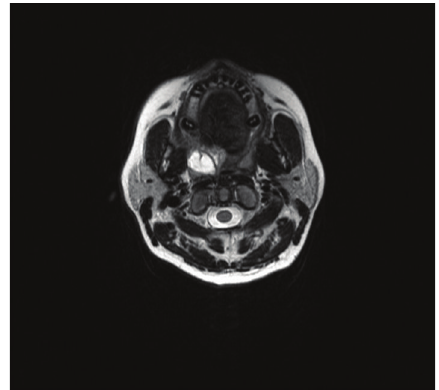
Figure 2: Axial MRI section of the spindle cell lipoma.